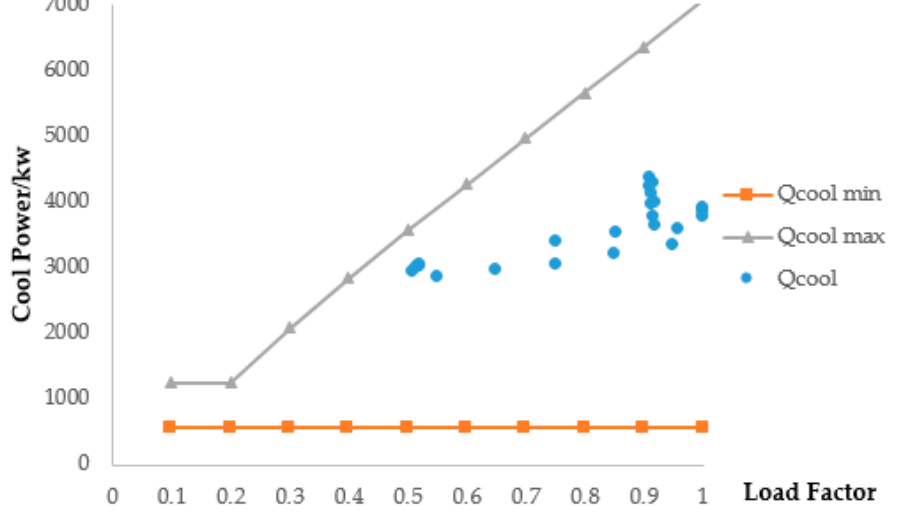
Figure 13. Multi-time scale cooling load-load rate operation.